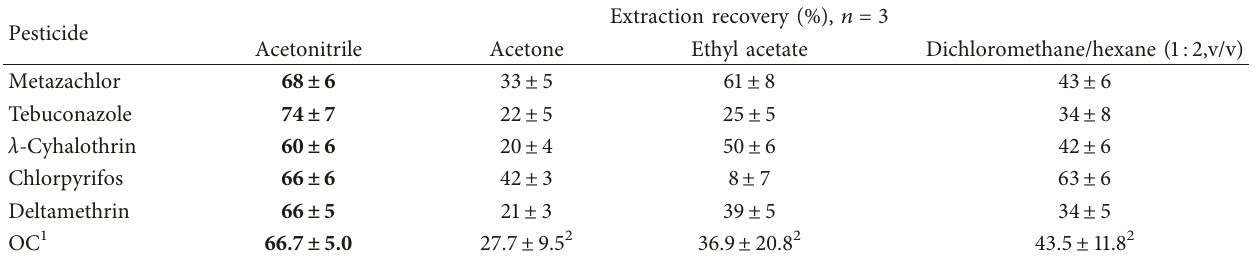
Table 2: Effect of the desorbing solvent type on extraction efficacy of the five pesticides from rape oil samples. Pesticide Tebuconazole